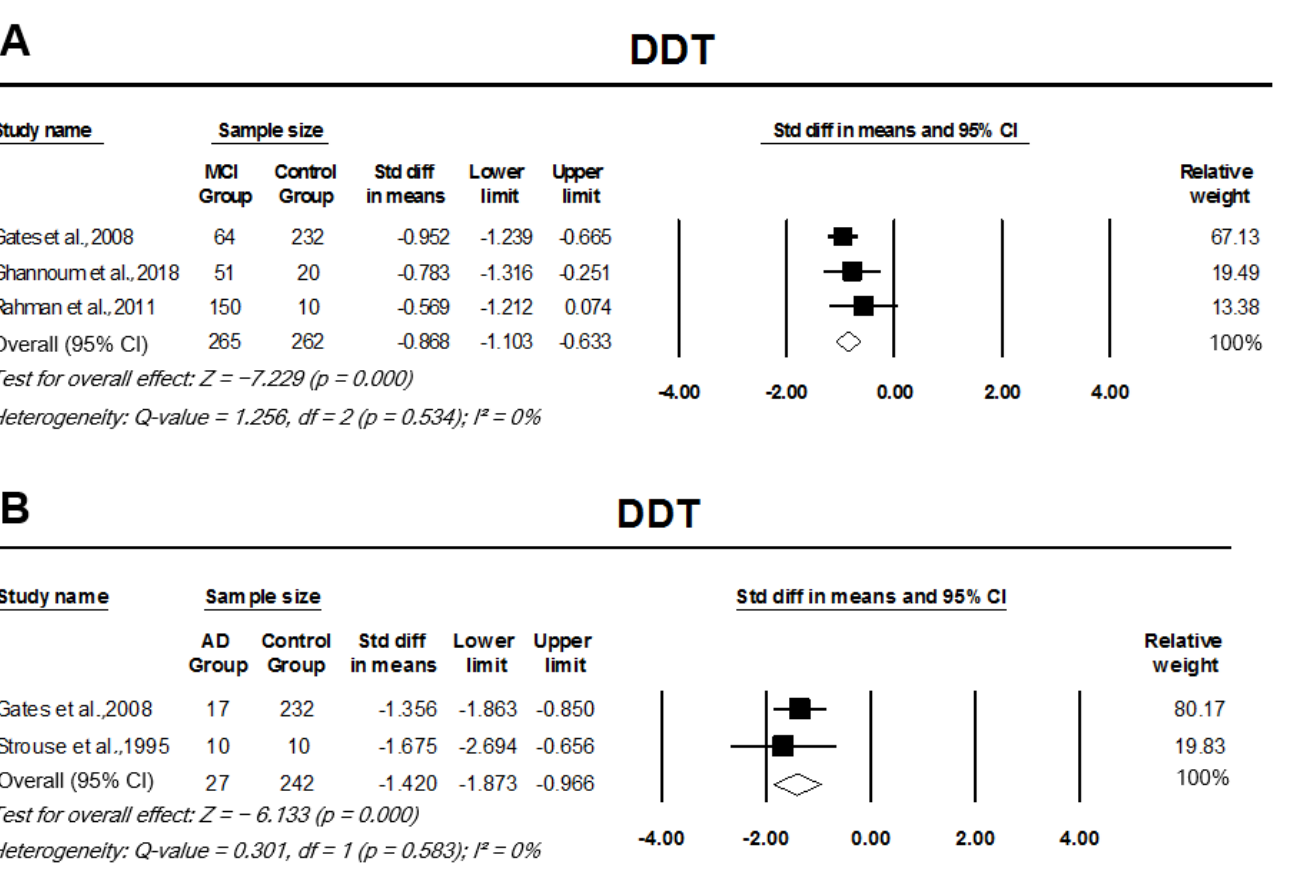
Figure 4. Forest plot of standard mean difference and overall (pooled) estimate of studies investigating dichotic digits test (DDT). ( A ) Analysis of DDT between the mild cognitive impairment (MCI) group and the control group, ( B ) analysis of DDT between the Alzheimer’s disease (AD) group and the control group. Notes: Z = Z score; I 2 = percentage of heterogeneity; Q-value = Cochrane’s Q; df = degrees of freedom. The horizontal lines represent the 95% confidence interval (CI) for each computed standard mean difference. Weights are from the random-effects analysis.